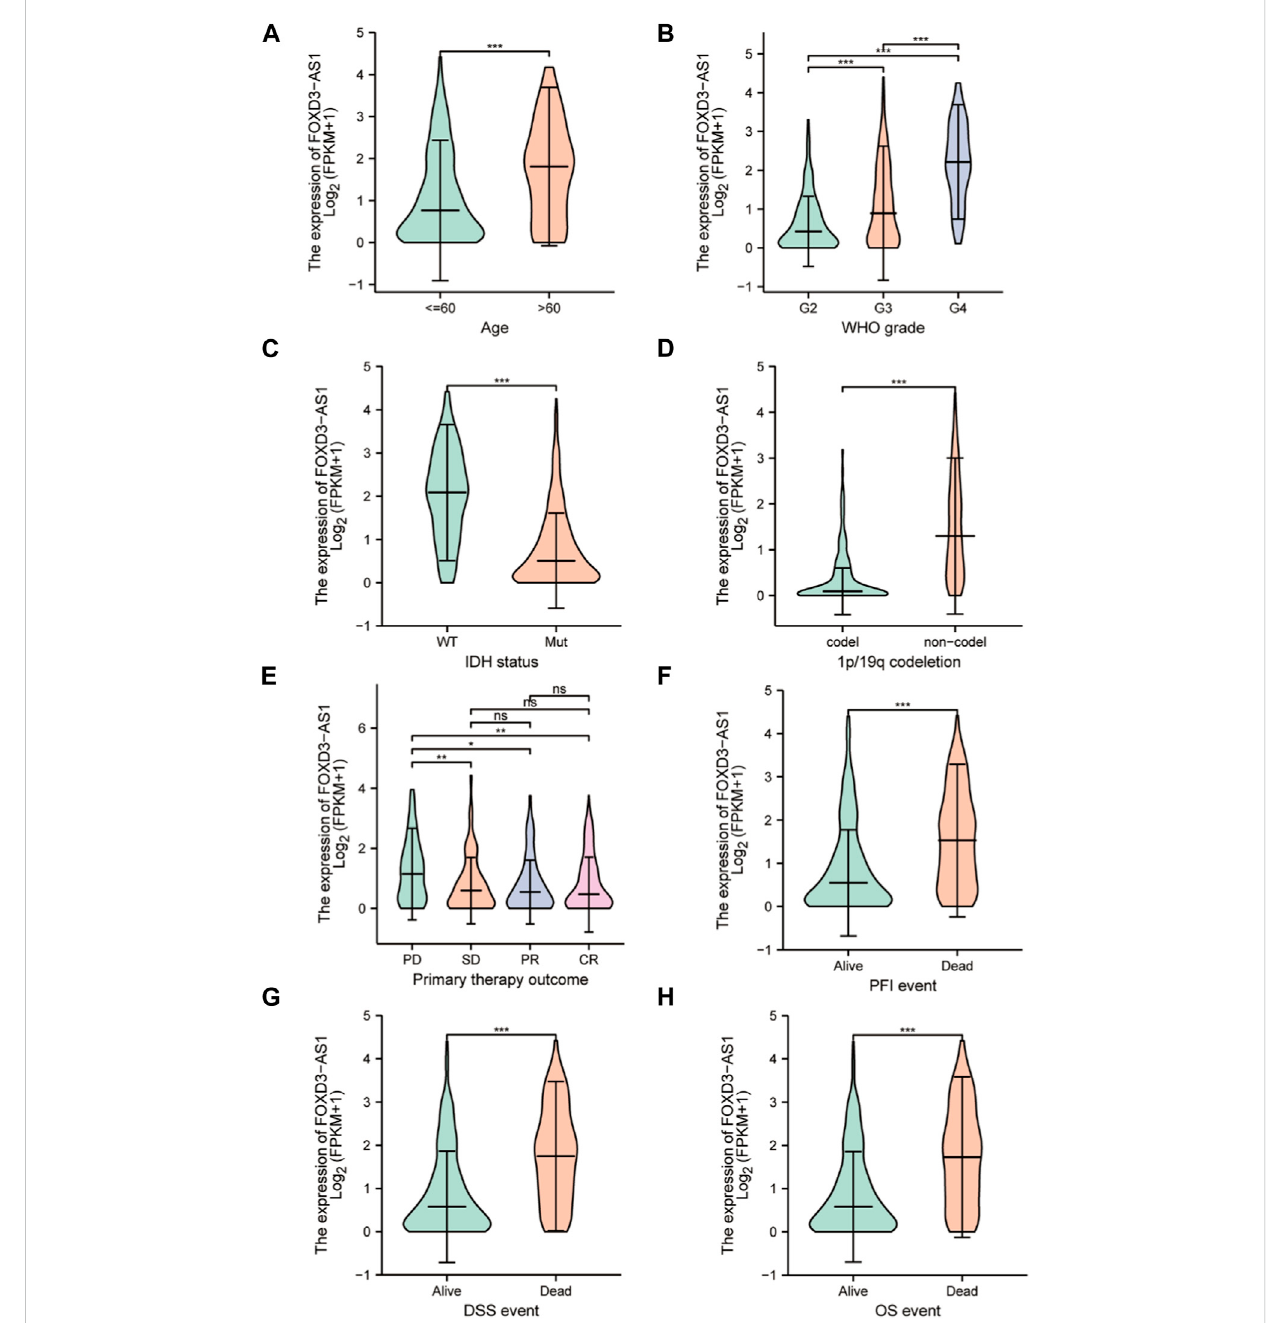
FIGURE 5 Determining the correlation between FOXD3-AS1 in TCGA and subgroups of GBM&LGG clinical variables. The box diagram shows the difference of FOXD3-AS1expressionamongthesubgroupsofclinicalvariablesofGBMandLGG,including (A) age, (B) WHOgrade, (C) IDHstatus, (D) 1p/19qcoding, (E, F) Primary therapy outcome, and the difference of expression among PFI (G) , DSS (H) , and OS survival